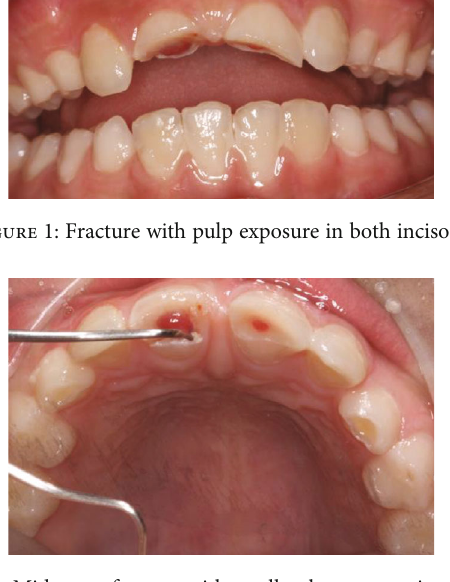
Figure 2: Midcrown fracture with small pulp exposure in tooth no. 21 and crown-root fracture with protrusive pulp reaction in tooth no. 11.